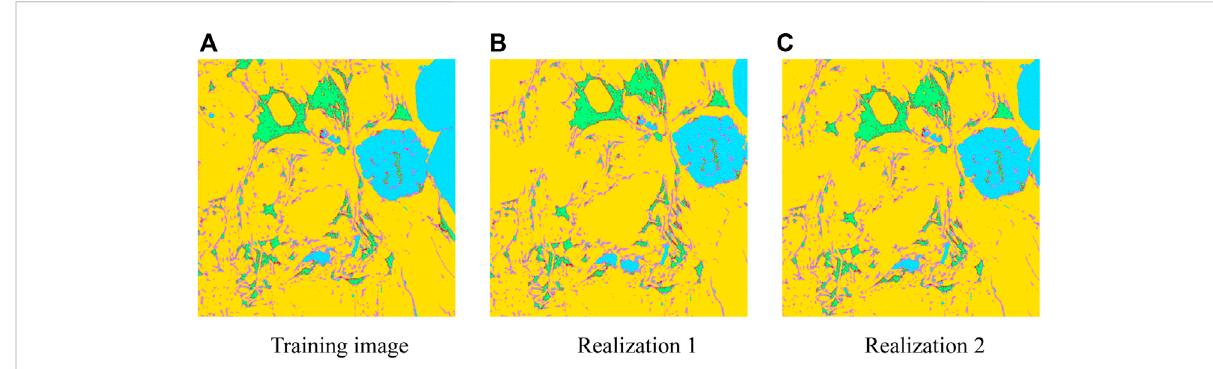
FIGURE 4 Comparison of 2D shale segmented digital rocks from the training image and different realizations. (A) Training image. (B) and (C) Realization 1 and 2, respectively, which were reconstructed using the suggested model. Red indicates the organic pore phase, green shows the organic matter phase, purple indicates the inorganic pore phase, yellow indicates the matrix, and light blue indicates the pyrite